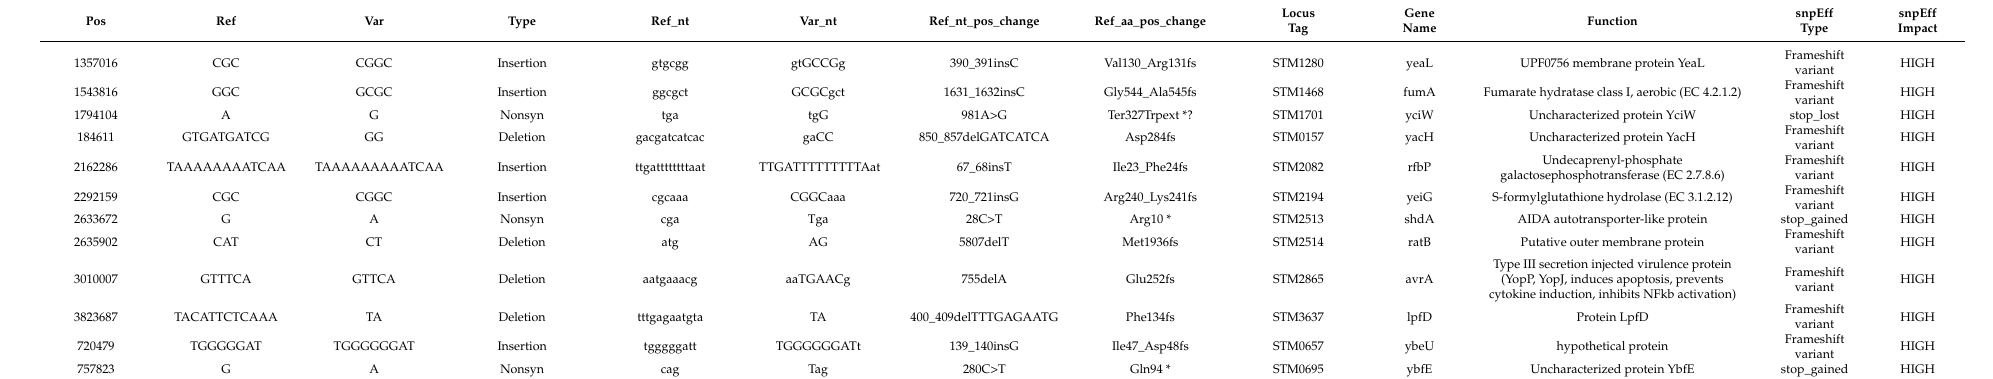
Ref: Salmonella enterica subsp. enterica serovar Typhimurium str. LT2, Var: Salmonella Typhimurium 4:i:1,2_69M, Ref_nt: reference nucleotide, Var_nt: variant nucleotide, Ref_nt_pos_change: reference nucleotide position change, Ref_aa_pos_change: reference amino acid position change, * Nonsyn: nonsynonymous substitution is a nucleotide mutation that alters the aminoacide sequence of a protein. This variant is defined as an alter in the DNA coding nucleotide that affects gene expression and protein production in different form